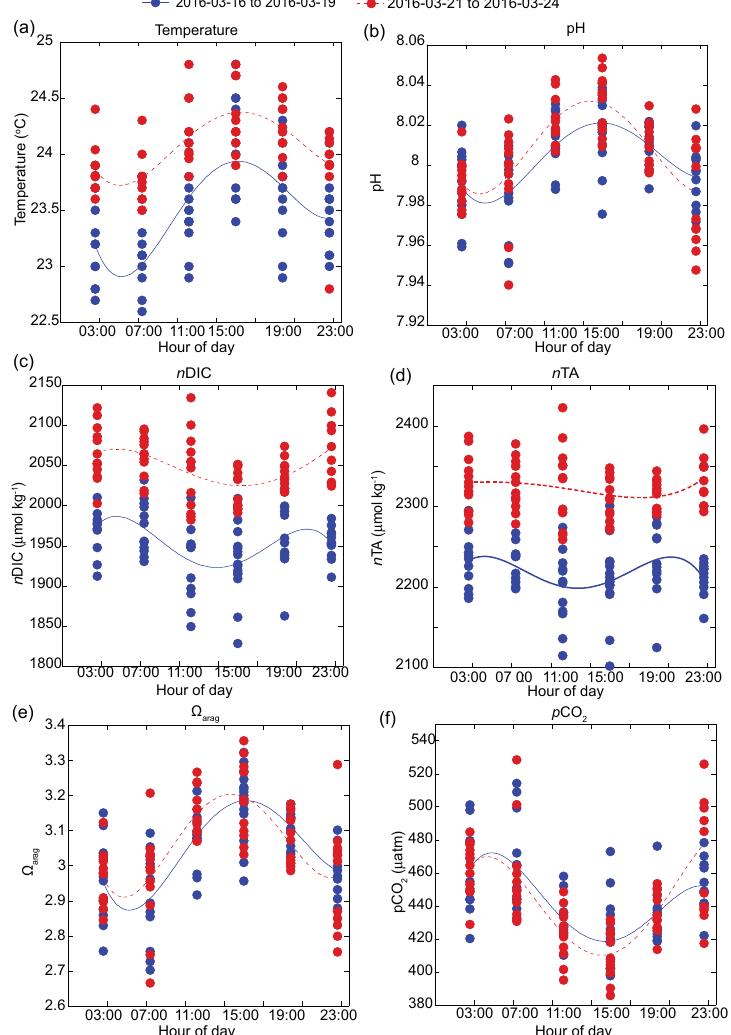
Figure 3. Carbonate chemistry parameters and sea surface temperature (SST) composite from S1, S2, S3, and S4 along the shallow reef flat of Kahekili, Maui, and cubic spline fits highlighting diurnal cycle for the first (16 to 19 March 2016; blue solid line) and second (21 to 24 March 2016; red dashed line) sampling periods for (a) temperature, (b) pH, (c) n DIC, (d) n TA (µmolkg − 1 ) , (e) (cid:127) arag , and (f) p CO 2